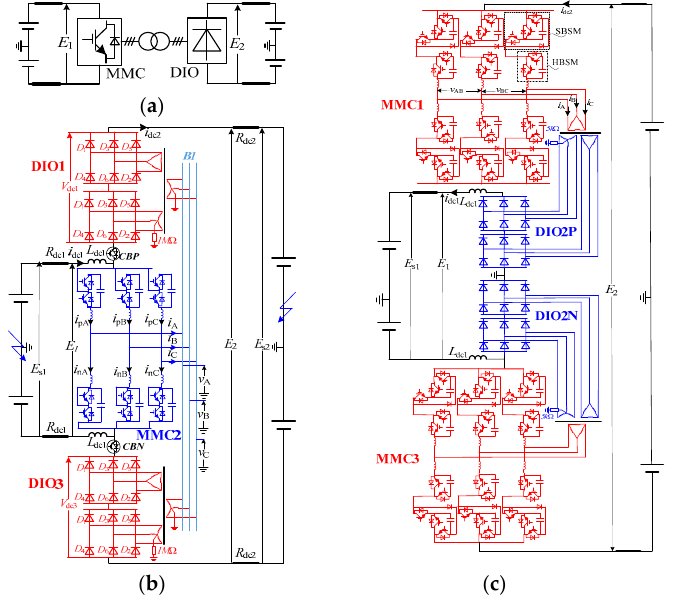
Figure 1. Topologies of unidirectional DC-AC-DC and unidirectional DC AUTOs. ( a ) Topology of conventional unidirectional DC-AC-DC; ( b ) Topology of a UUDAT; ( c ) Topology of a